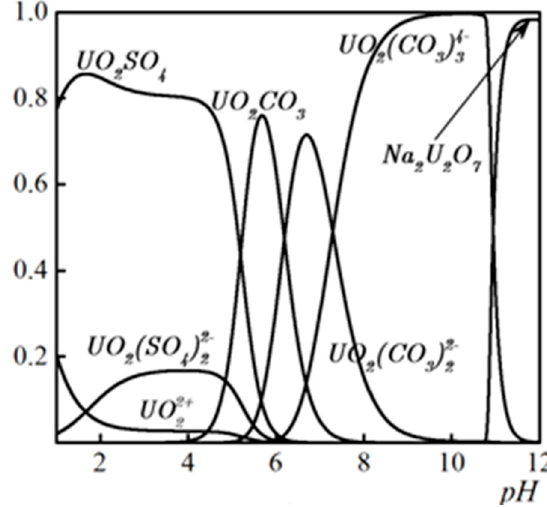
Figure 9. U(VI) speciation in mineralized groundwater.